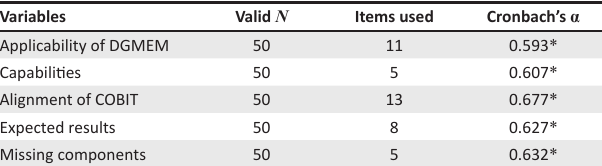
TABLE 2: Reliability